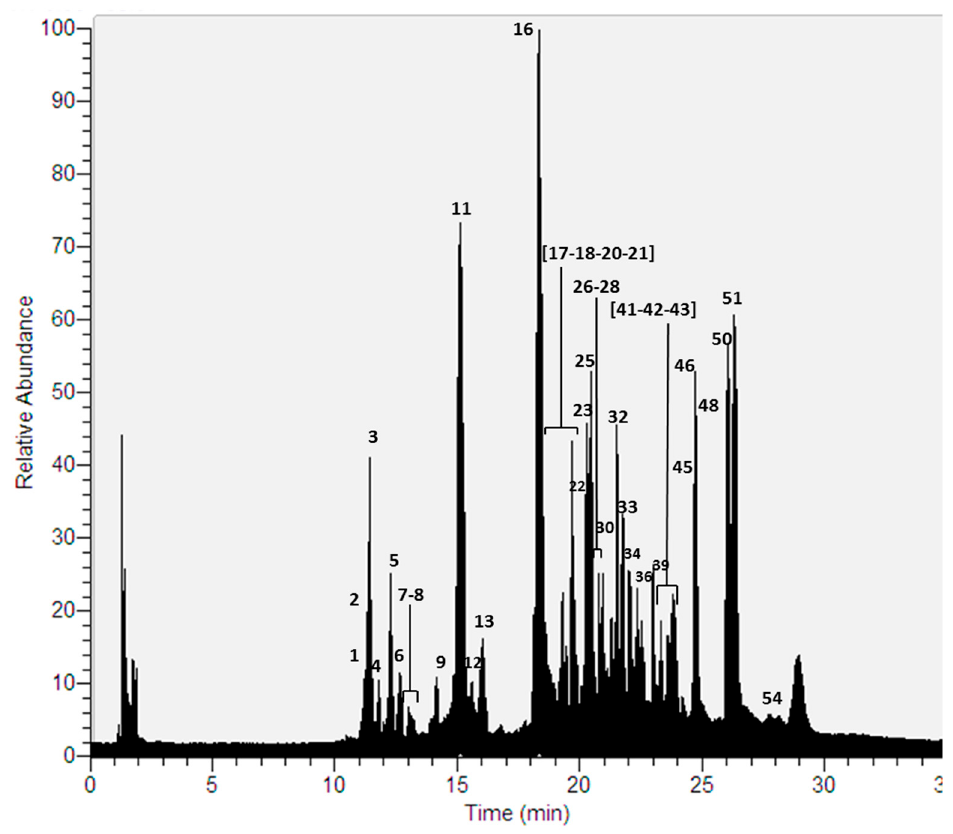
Figure 2. UHPLC Chromatogram of P. robustum .